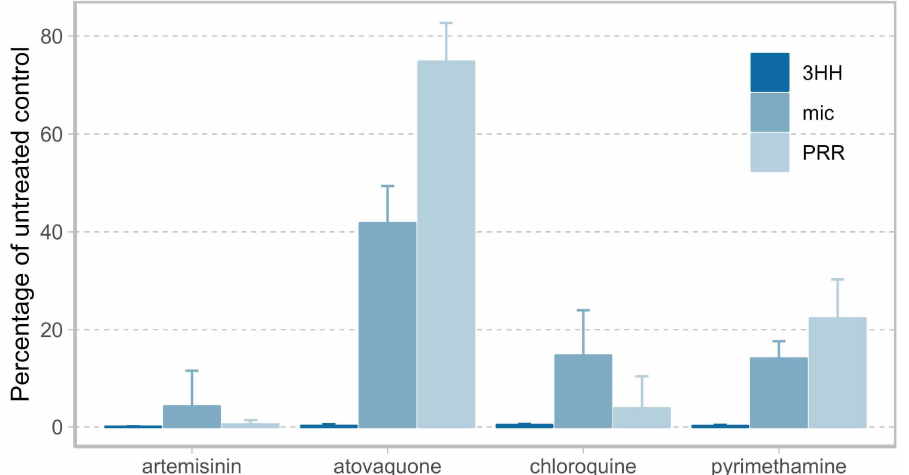
Figure 1. Comparison of drug activity after 72 h of drug exposure as determined by [ 3 H] hypoxan- thine incorporation (3HH, dark blue), microscopy (mic, blue), and by Parasite Reduction Ratio (PRR) assay (PRR, light blue) from three biological replicates with one, two, and four technical replicates for the microscopic-, [ 3 H] hypoxanthine incorporation-, and the PRR assay, respectively. Resolution of drug activity is highest when measuring parasite viability using the PRR assay with compounds in order of decreasing activity: artemisinin, chloroquine, pyrimethamine, atovaquone. Artemisinin, chloroquine and pyrimethamine were examined at ten times the 50% inhibitory concentration (IC 50 ), atovaquone at a concentration of 100